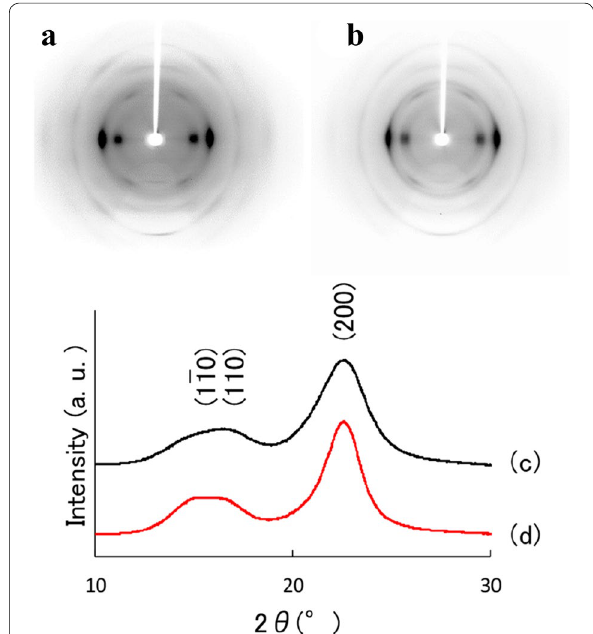
Fig. 7 a , b X-ray diffraction patterns, and c , d X-ray diffractograms. a , c are obtained from the untreated wood while b and d are from the colorless wood, respectively